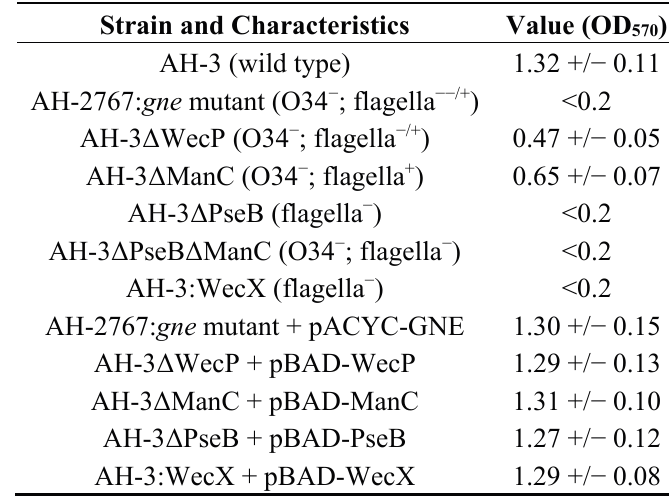
Table 2. Biofilm values of several A. hydrophila strains using the method of Pratt and Kolter as indicated in the Experimental Section. Values presented are mean +/ − SD from three independent experiments carried out in triplicates ( n =